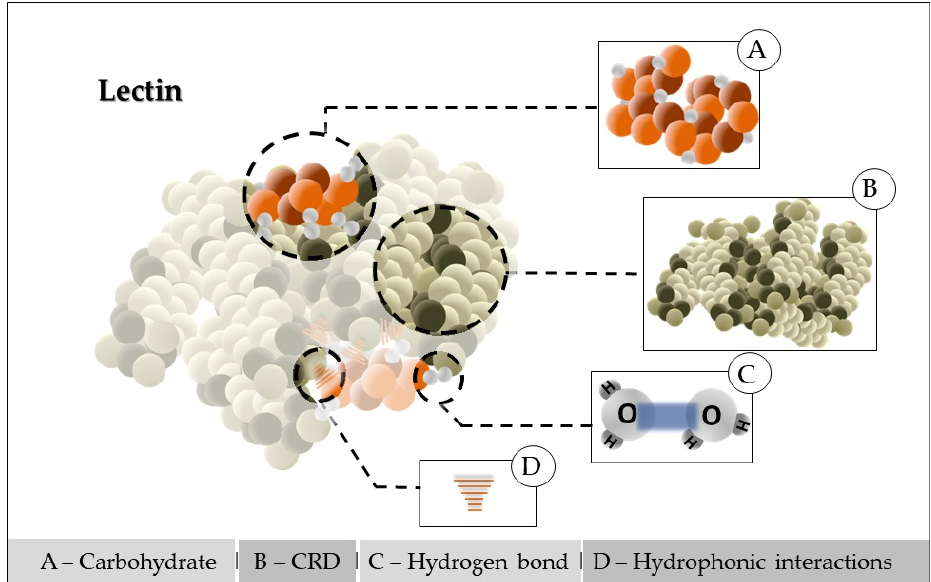
Figure 1. Scheme illustrating the binding of lectin to the carbohydrate through the carbohydrate recognition domain. The carbohydrate–lectin interaction involves, among other non-covalent forces, the formation of hydrogen bonds and hydrophobic